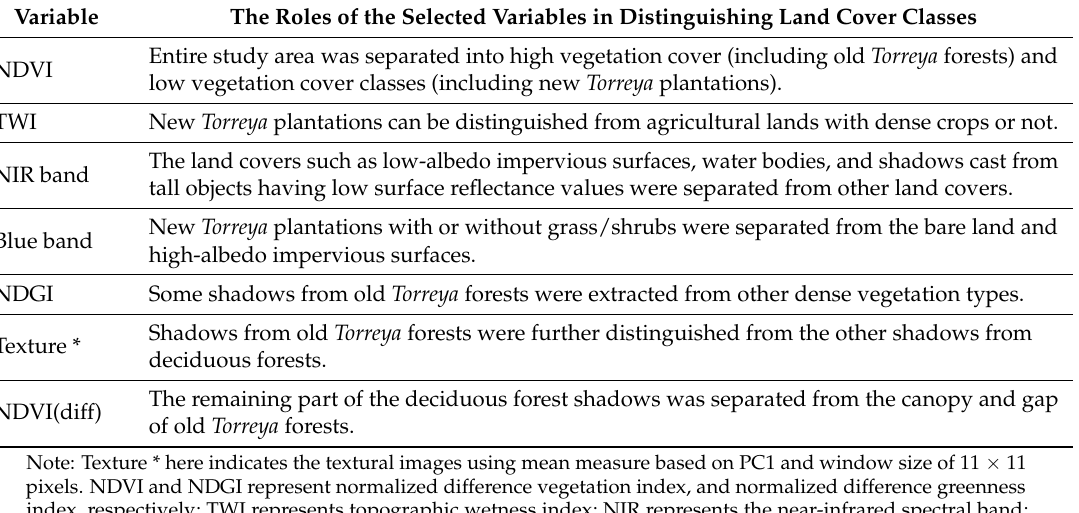
Table 2. Selected variables for extraction of old Torreya forests and new Torreya plantations.